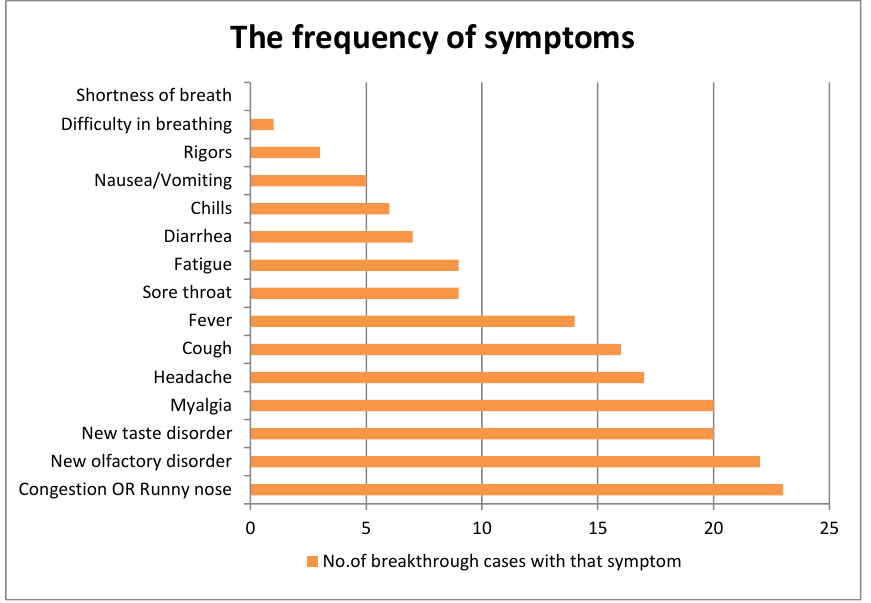
Figure 2. The frequency of 15 symptoms of breakthrough cases. X-axis: number of breakthrough cases with that symptom, Y-axis: symptom.